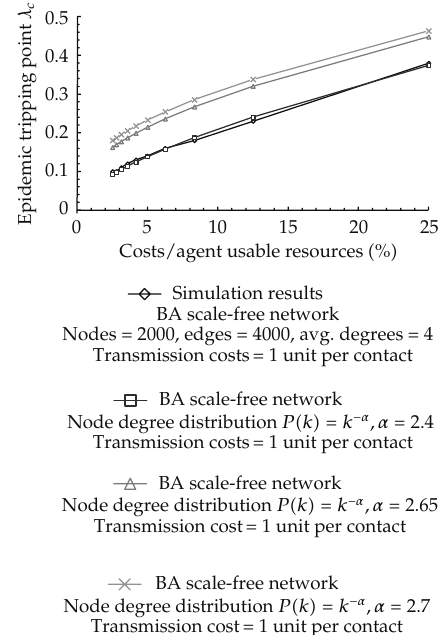
Figure 5: As a function of the c/R (cid:3) interaction costs/agent resources (cid:4) ratio in scale-free networks, epidemic tipping point λ c was used to analyze results from a simulation and three mathematical